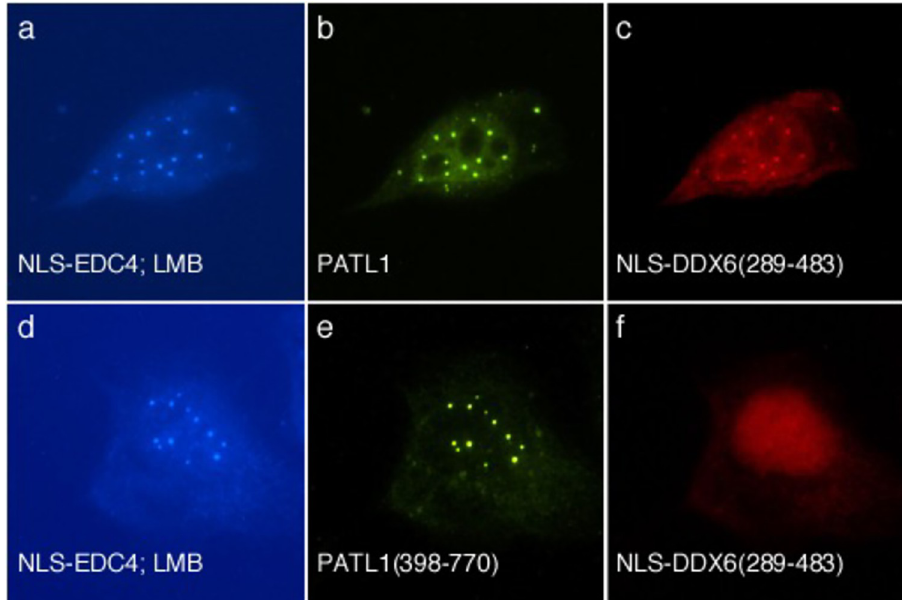
Fig 6. DDX6 interacts with PATL1. Co-expression of NLS-EDC4 (panel a), GFP-PATL1 (panel b) and monomeric cherry (mCh)-NLS-DDX6(289–483) (panel c) followed by treatment with leptomycin B (LMB) resulted in co- localization of the proteins in nuclear dots in 81+/-5% of cells expressing all three proteins. Faint, diffuse nuclear staining of mCh-NLS-DDX6(289–483) was also detected. Co-expression of NLS-EDC4, GFP-PATL1(398–770) and mCh-NLS-DDX6(289–483 followed by treatment with LMB resulted in localization of NLS-EDC4 (panel d) and GFP-PATL1(398–770) (panel e) in nuclear dots. However, in cells expressing all three proteins, mCh-NLS-DDX6 (289–483) was not detected in nuclear dots (panel f). Human serum containing anti-EDC4 antibodies and coumarin- conjugated donkey anti-human IgG antiserum were used to detect NLS-EDC4 in a and d. Mouse monoclonal anti- GFP antibody detected GFP-PATL1 (panel b) and GFP-PATL1(398–770) (panel e). Rabbit anti-mCh antiserum detected mCh-NLS-DDX6(289–483) in c and f.